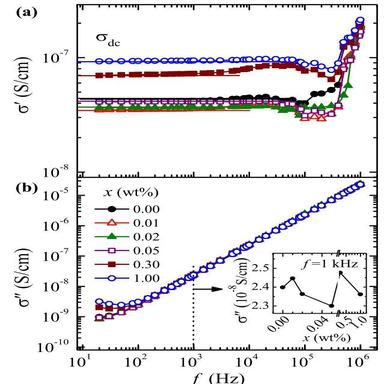
Complex alternating current (ac) electrical conductivity (r0 and r00) spectra for the GLY/x (wt%) ZnO nanofluids (x = 0.00, 0.01, 0.02, 0.05, 0.30, and 1.00), at 25 C. Horizontal solid lines in (a) represent the dc conductivity rdc plateau and the inset of (b) shows the variation of r00 with x (wt%) amounts of ZnO for the nanofluids at 1 kHz.